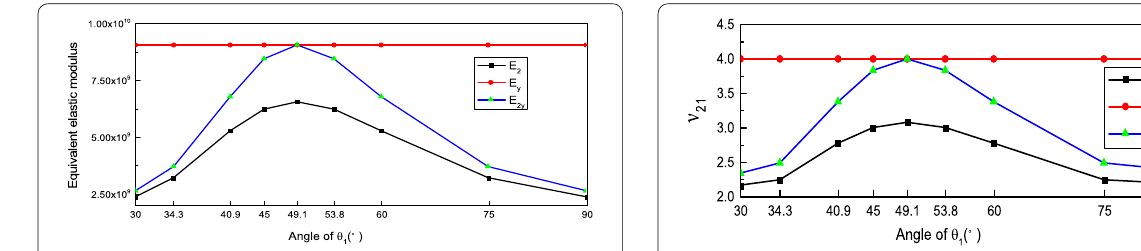
Figure 11 Elastic modulus E 2 with varying θ 1 angle in the σ 2 direction